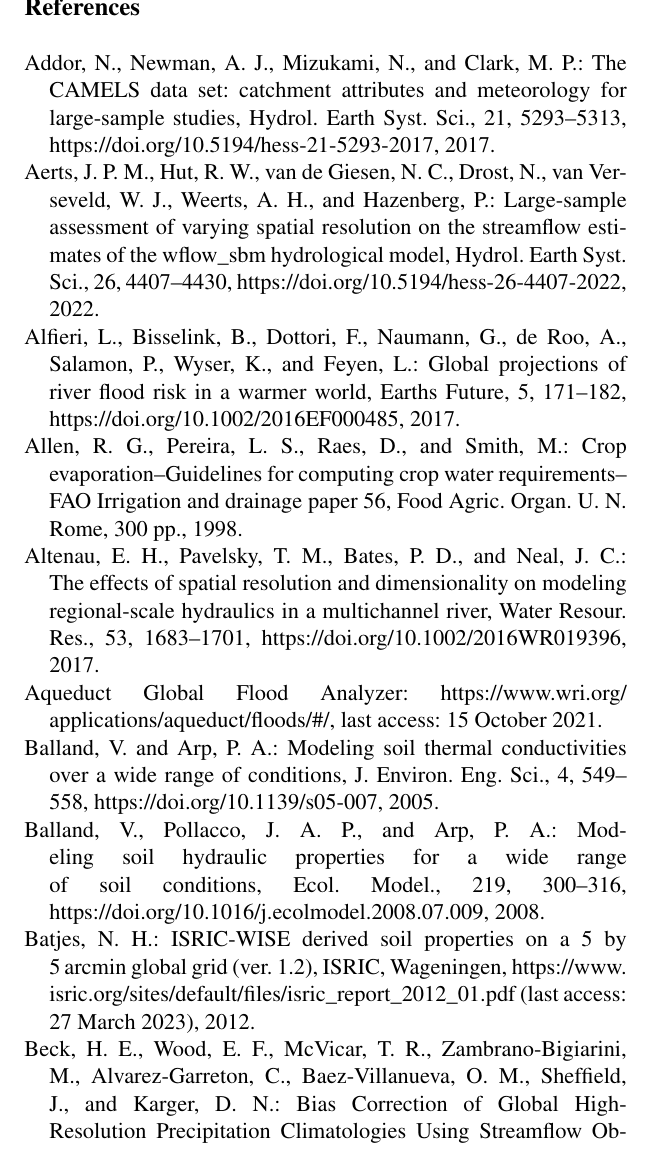
Figure B5. Categorization of water provinces according to their R 2 and RRMSE values. Grey hatching refers to water provinces for which the snow cover correction of TWS anomaly was effective (see Sect.